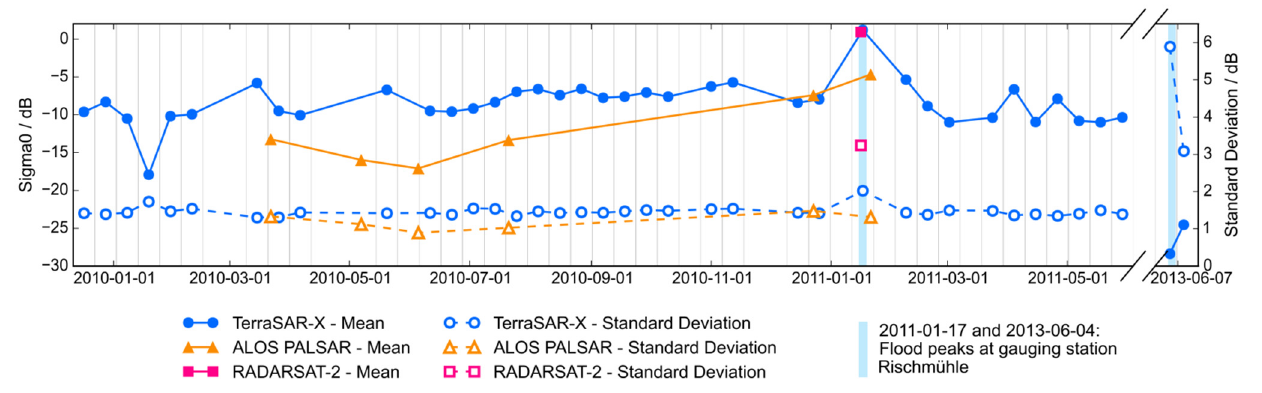
Figure 10. Time course of σ 0 (dB): Mean and standard deviation for test class 6 (flooded